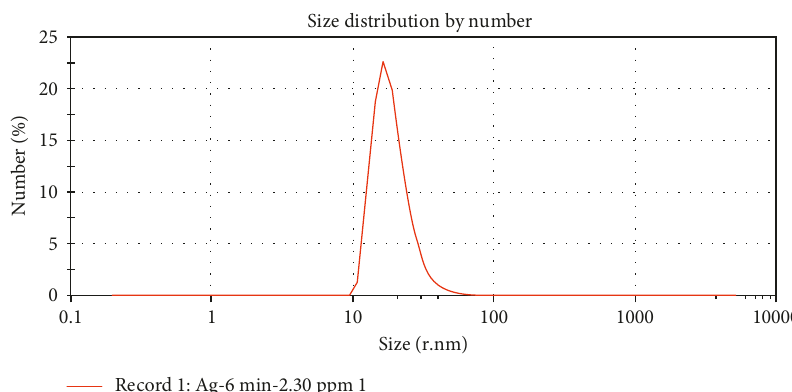
Figure 14: Particle size distribution of aqueous colloid silver (arcing in DW for 6 min).